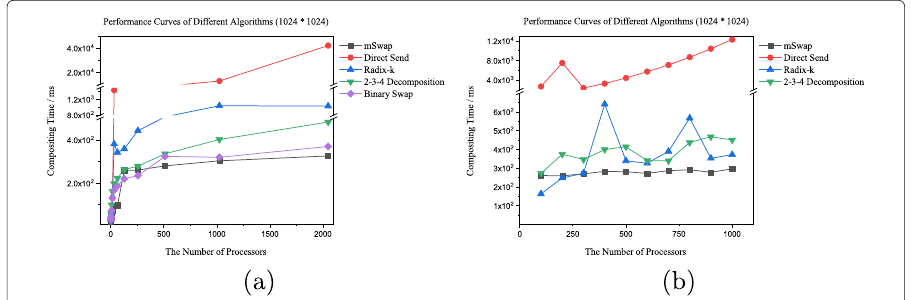
Fig. 8 Performance curves of different algorithms with a resolution of 1024 ∗ 1024. a is the compositing time when the number of processors is power-of-two. b is the compositing time when the number of processors is non power-of-two without Binary